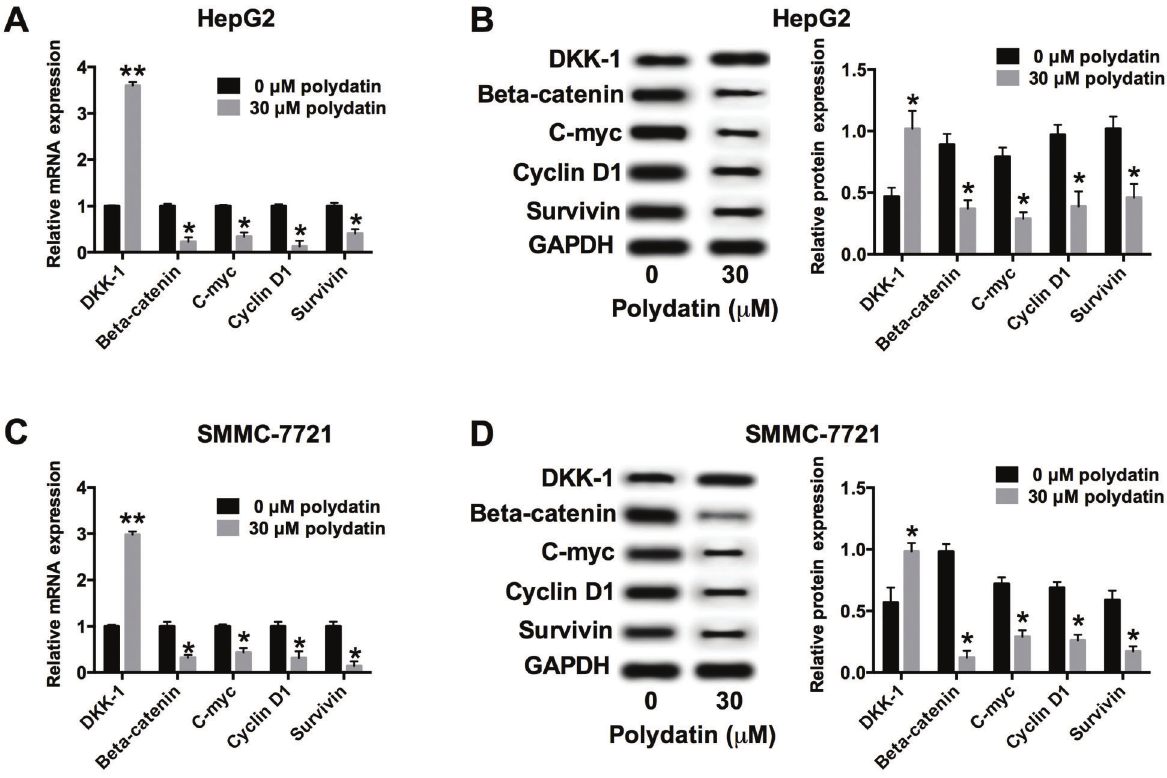
Figure 4. Effects of polydatin on Wnt/beta-catenin signaling activity in liver cancer cell lines. A , mRNA expression levels and B , protein levels of DKK-1, beta-catenin, c-myc, cyclin D1, and survivin in HepG2 cells determined by qRT-PCR and western blot assay, re- spectively; C , mRNA expression levels and D , protein levels of DKK-1, beta-catenin, c-myc, cyclin D1, and survivin in SMMC-7721 cells. Data are reported as means ± SD. All experiments were repeated 3 times. *P o 0.05, **P o 0.01 compared to control group (Student ’ s t